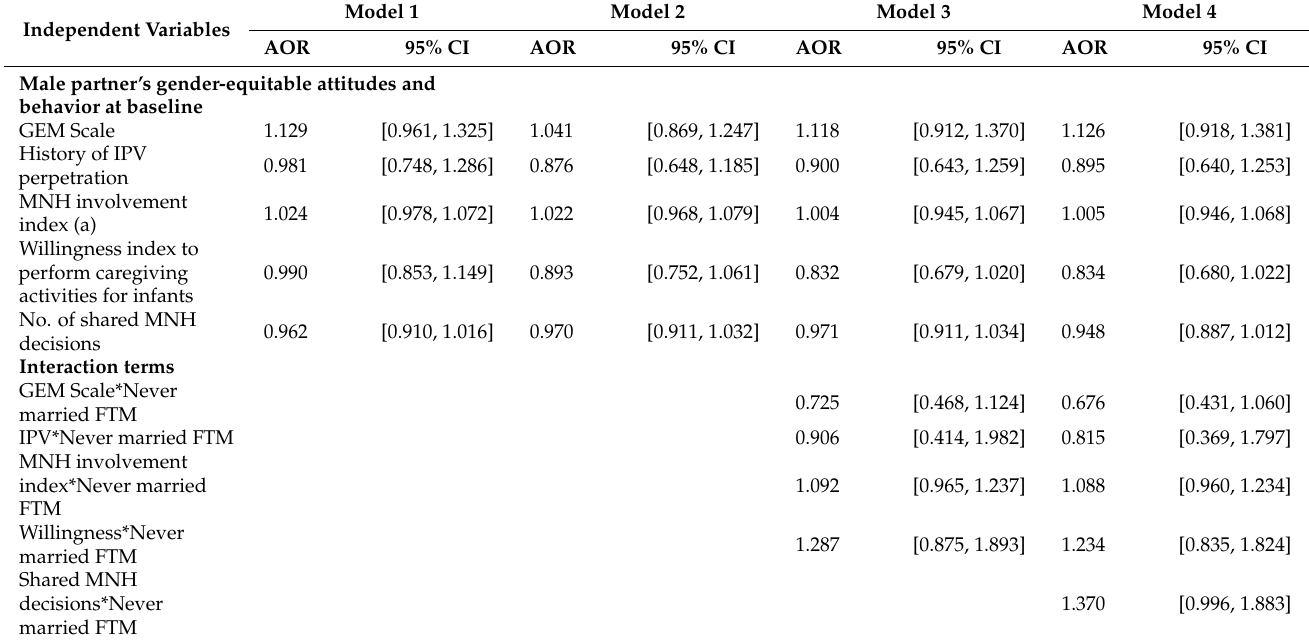
Table 7. Results of multivariable logistic regression models of completion of the maternal health continuum of care, first-time mothers age 15–24, Kinshasa,